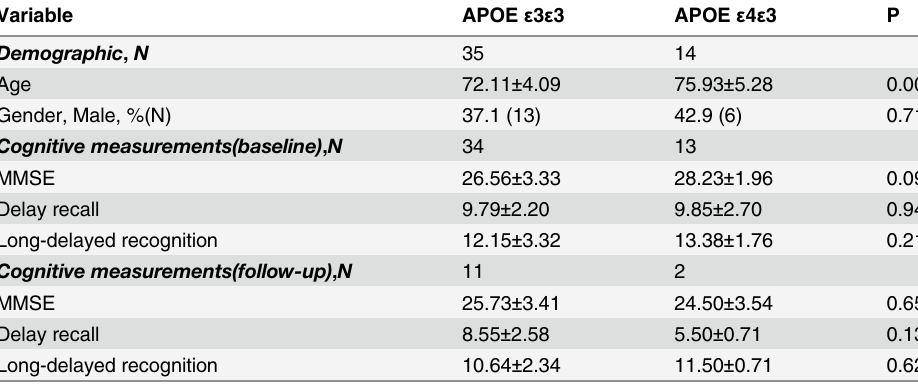
Table 2. Comparison of demographic information and cognitive measurements between APOE ε 3 ε 3 and ε 4 ε 3